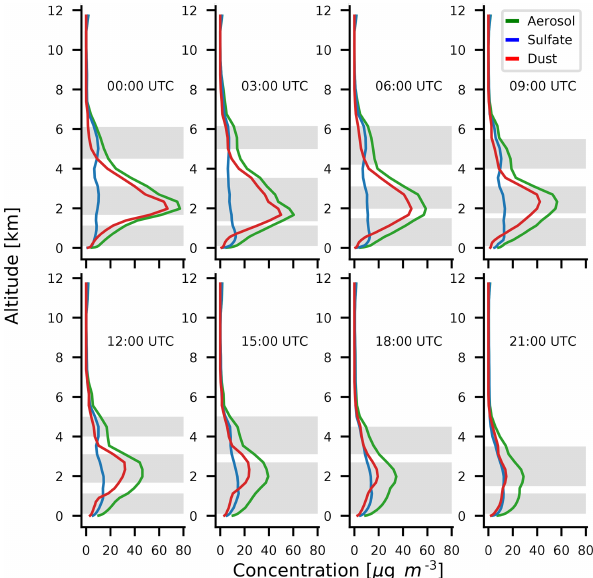
Figure 4. CAMS total aerosol, sulfate, and dust profiles for 2 April 2014, Pillersdorf. The gray area represents the identified sulfate layers. Altitudes are given in kilometers above ground level. Local time is UTC+2. Table 1. Association of layers from lidar measurements with layers and trajectories computed for Pillersdorf, 02 April 2014, 06:00. Lidar station, Pillersdorf